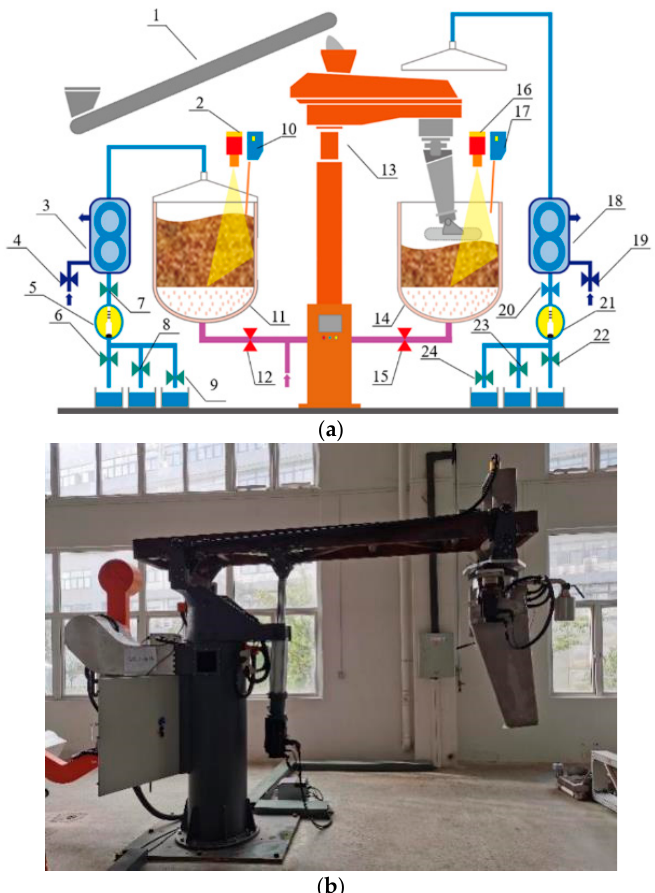
Figure 8. Robot for steamer-filling. ( a ) Design of intelligent distillation system using a robot for steamer-filling (1, conveyor; 2 and 16, temperature detector; 3 and 18, condenser; 4 and 19, valve for cooling water; 5 and 21, detector of alcohol content; 6 and 22, valve for foreshot of liquor; 7 and 20, main valve for distillate; 8 and 23, valve for liquor body; 9 and 24, valve for tail liquor; 10 and 17, detector of grain surface; 11 and 14, Zeng; 12 and 15, steam valve; 13, steamer-filling robot); ( b ) Digital figure of robot for steamer-filling (the figures are all kindly supplied by Wuhan Fenjin Intelligent Machine Co., Ltd., Wuhan,